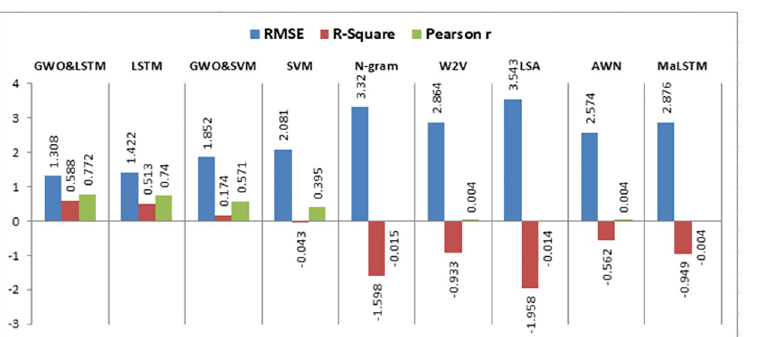
Fig 26. LSTM-GWO performance evaluation with experiment 4.